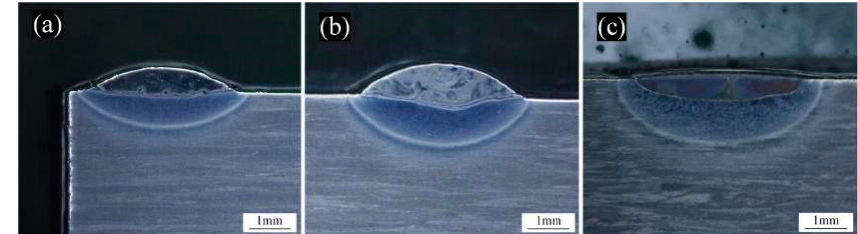
Figure 3. Surface morphology of high entropy alloy laser cladding layer under different specific energies. ( a ) 40.9 J/mm 2 ; ( b ) 58.3 J/mm 2 ; ( c ) 89.3 J/mm 2 .